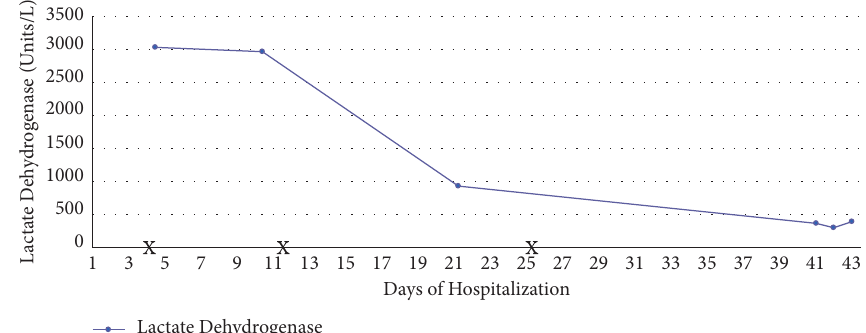
Figure 4: Trend of lactate dehydrogenase the throughout hospital course. X reflects eculizumab